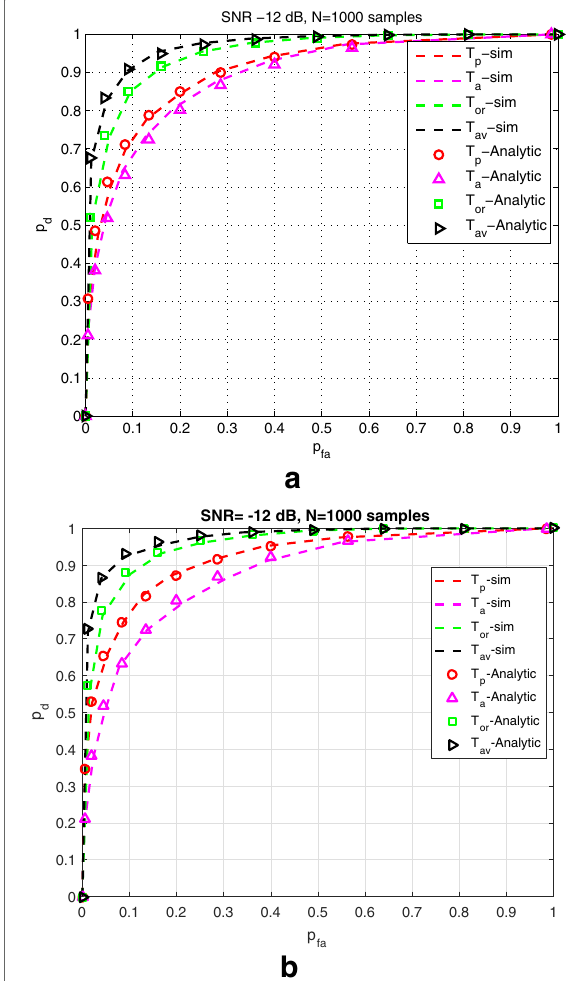
Figs. 3a, b. Simulations were done under following con- ditions: 16-QAM modulation, γ = − 12 dB, N = 1000 samples, and N s = 4 sps.